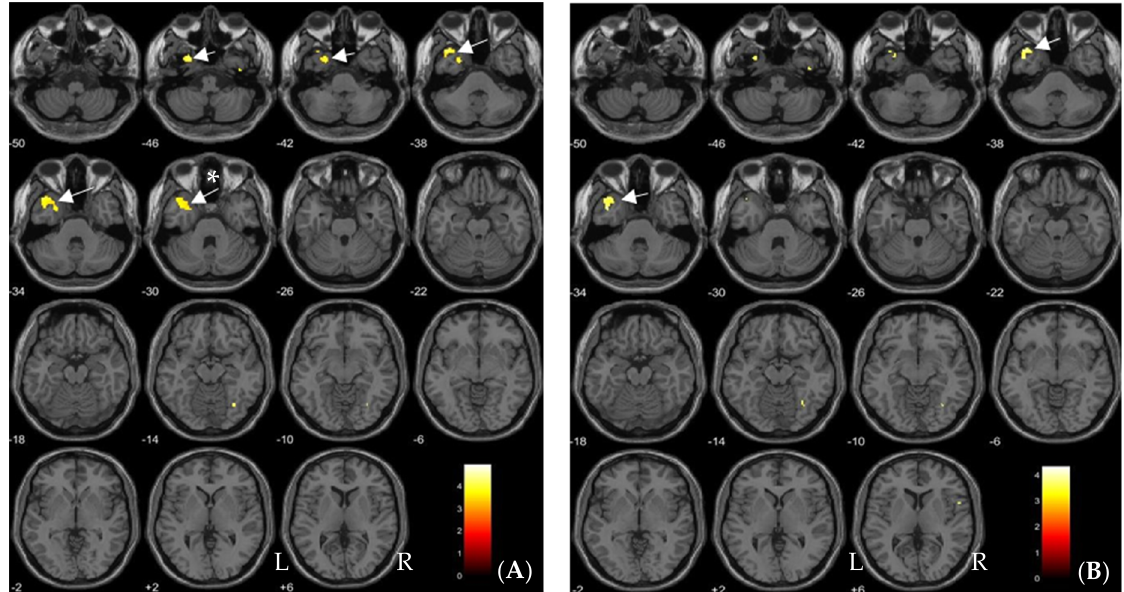
Figure 2. Brain regions showing significant negative correlations with blood levels of TCDD ( A ) and TEQ ‐ PCDDs ( B ) (FDR ‐ corrected at p < 0.05) are indicated by yellow color and arrows on axial MRI. ( A ) shows the correlations in the left medial temporal pole (arrows without *) and fusiform gyrus (an arrow with *) and ( B ) shows those in the left medial temporal pole (arrows). L and R indicate the left and right sides of the hemispheres, respectively. Each value below each brain slice indicates each value in MNI z ‐ coordinates.